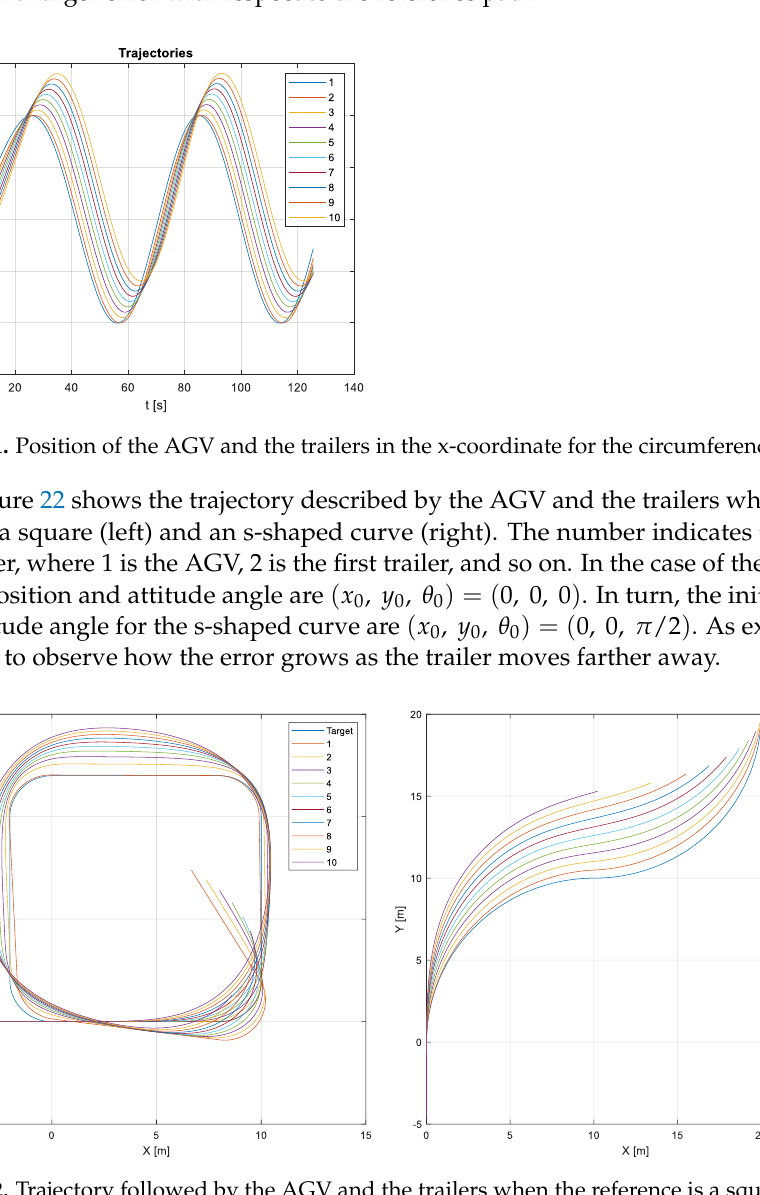
Figure 22. Trajectory followed by the AGV and the trailers when the reference is a square ( left ) and an s-shaped curve ( right ).